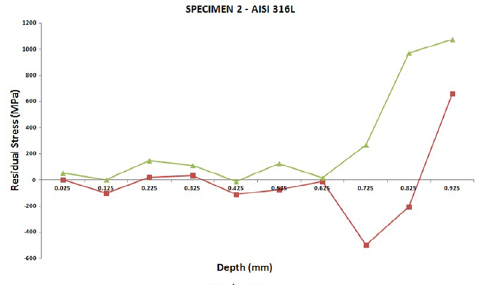
Figure 7. Distribution of the minimum and maximum residual stresses in specimen 2, contemplating the interface region between BM and HAZ of stainless steel AISI 316L